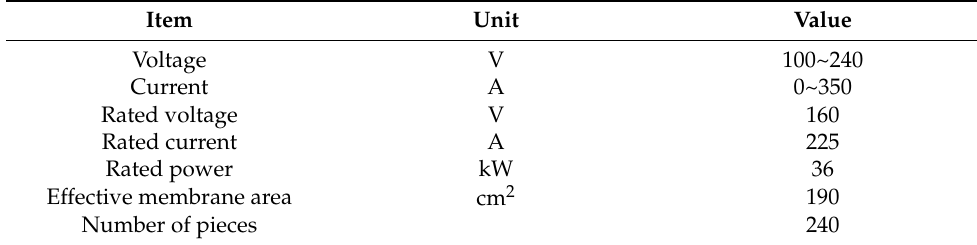
Table 2. Basic parameters of Stack